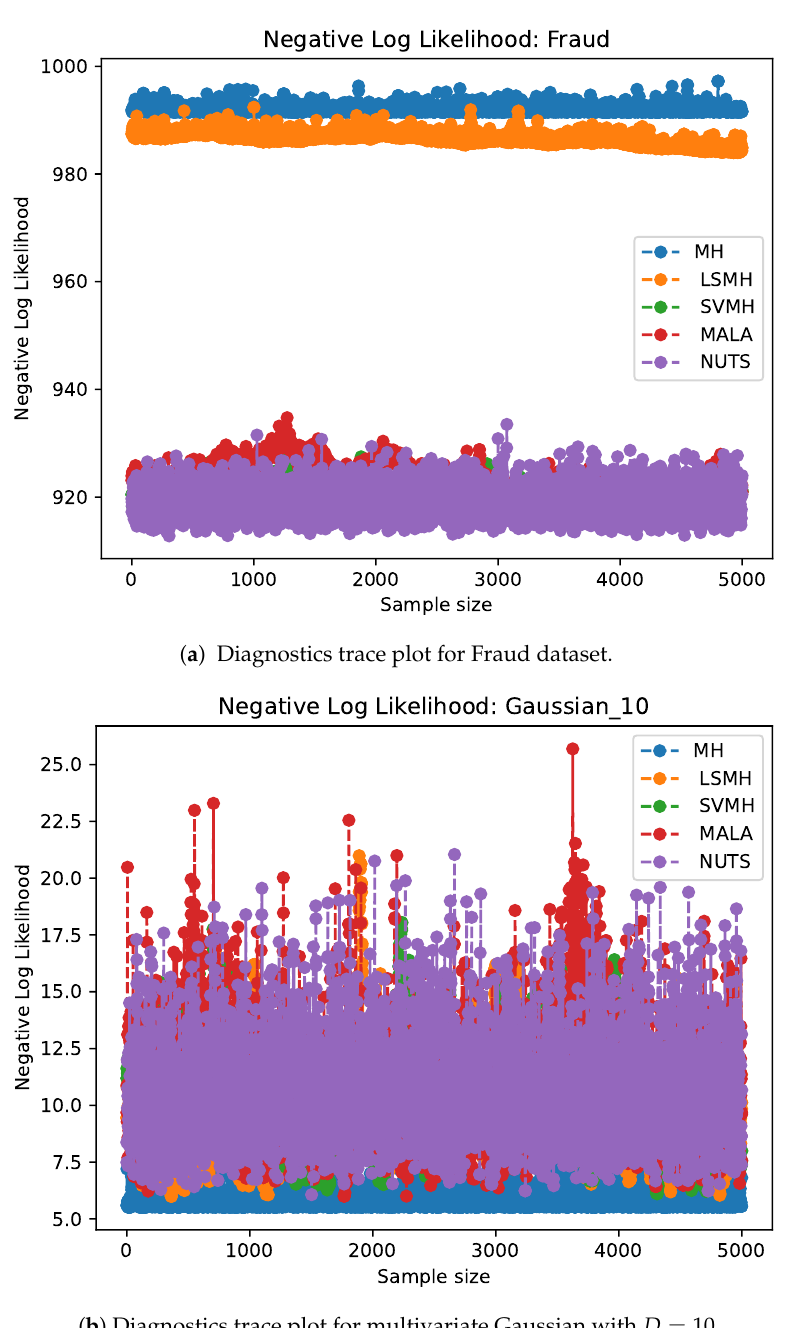
( b ) Diagnostics trace plot for multivariate Gaussian with D = 10. Figure 2. Negative log-likelihood diagnostic trace plots for various targets. These are traces plots from a single run of the MCMC chain. ( a ) Diagnostic negative log-likelihood trace plots for the Fraud dataset and ( b ) Diagnostic negative log-likelihood trace plots for the multivariate Gaussian with D = 10. The other targets produce similar convergence